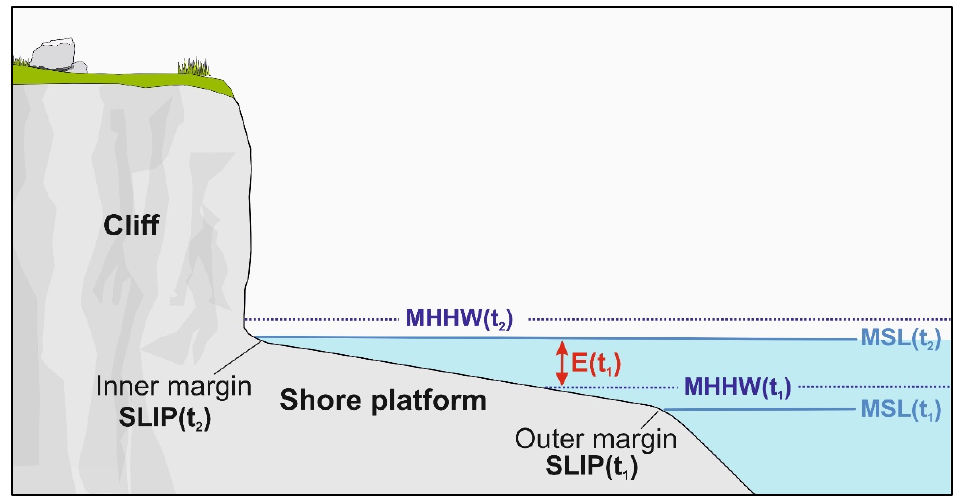
Figure 3. Shore platform as sea-level index point (SLIP).